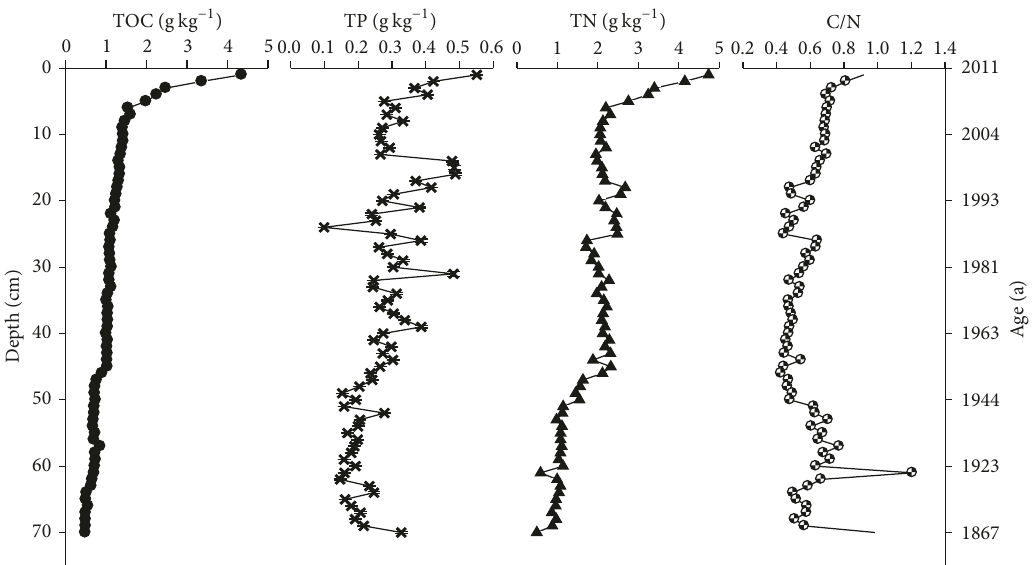
Figure 3: Vertical distribution of TOC, TN, TP, and C/N in the